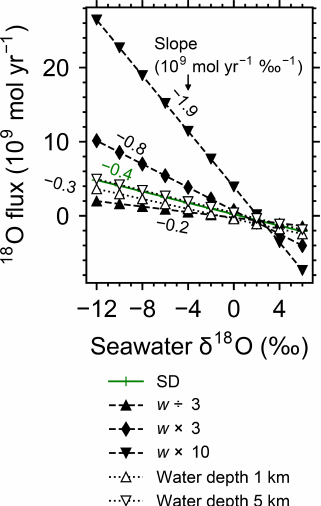
Figure 9. Net 18 O flux to the ocean from hydrothermal systems as a function of seawater δ 18 O from simulations with different spread- ing rates and ocean depths. See the legend for the types of symbol and line for individual simulations. Slope values are denoted near the